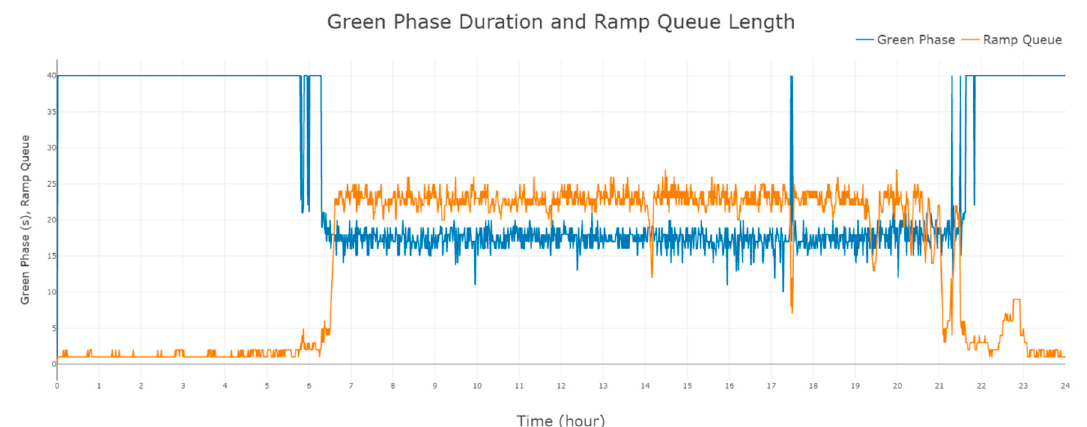
Figure 18. Green phase duration and ramp queue length—the proposed metering